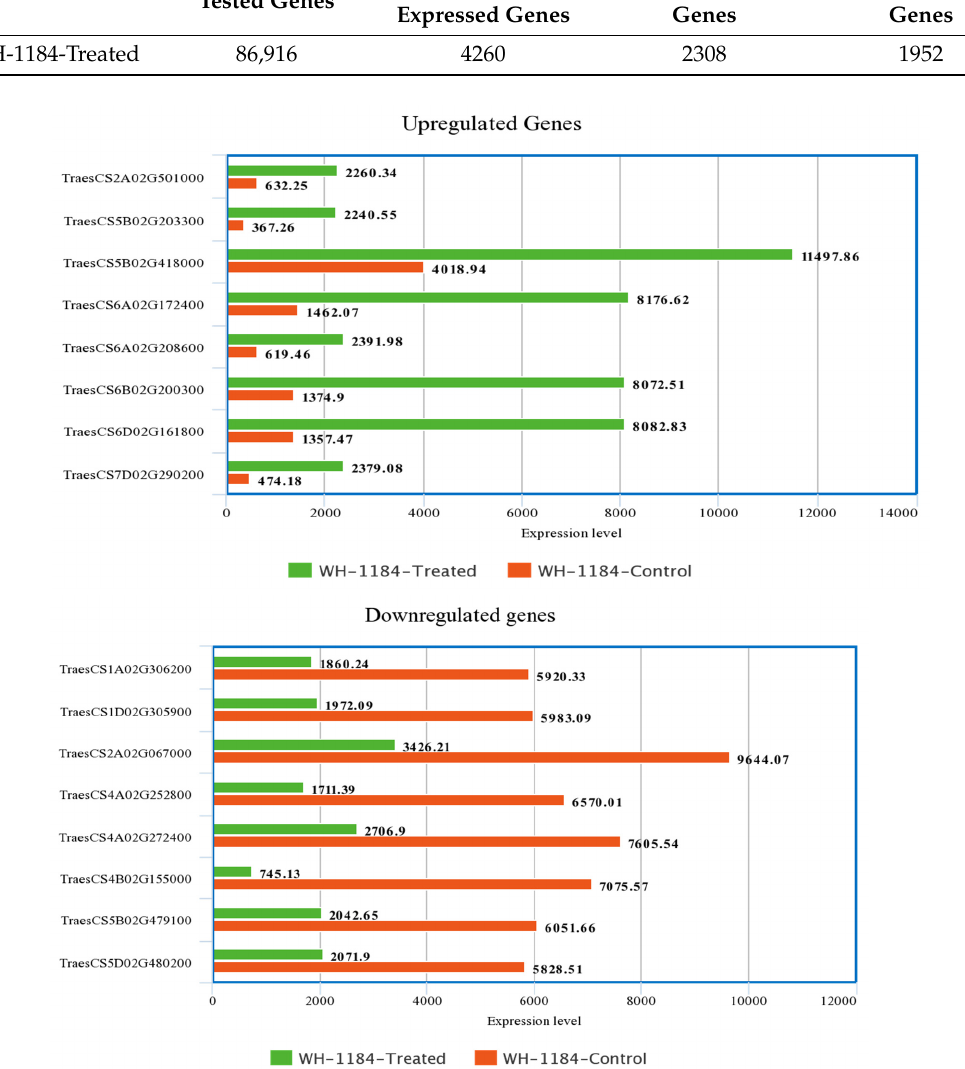
Table 5. Differentially expressed genes (DEGs) in WH-1184 under both the conditions. Condition